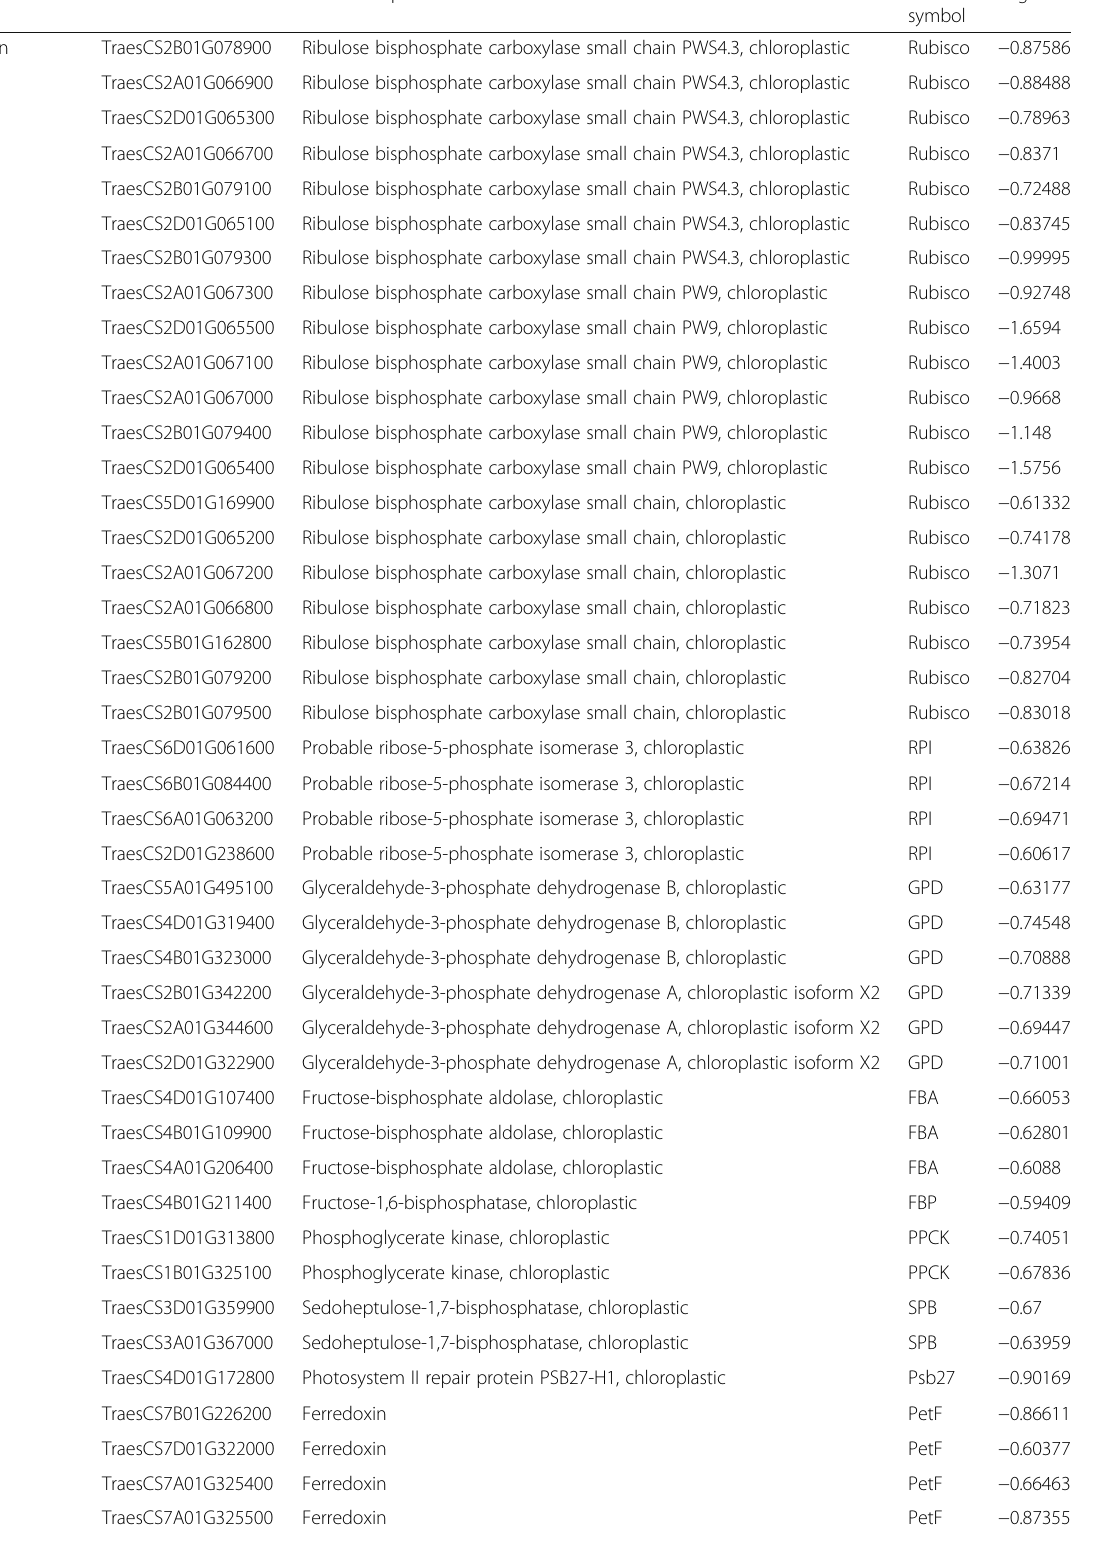
Table 3 List of differentially expressed genes related to photosynthesis and chlorophyll Pathway Carbon fixation in